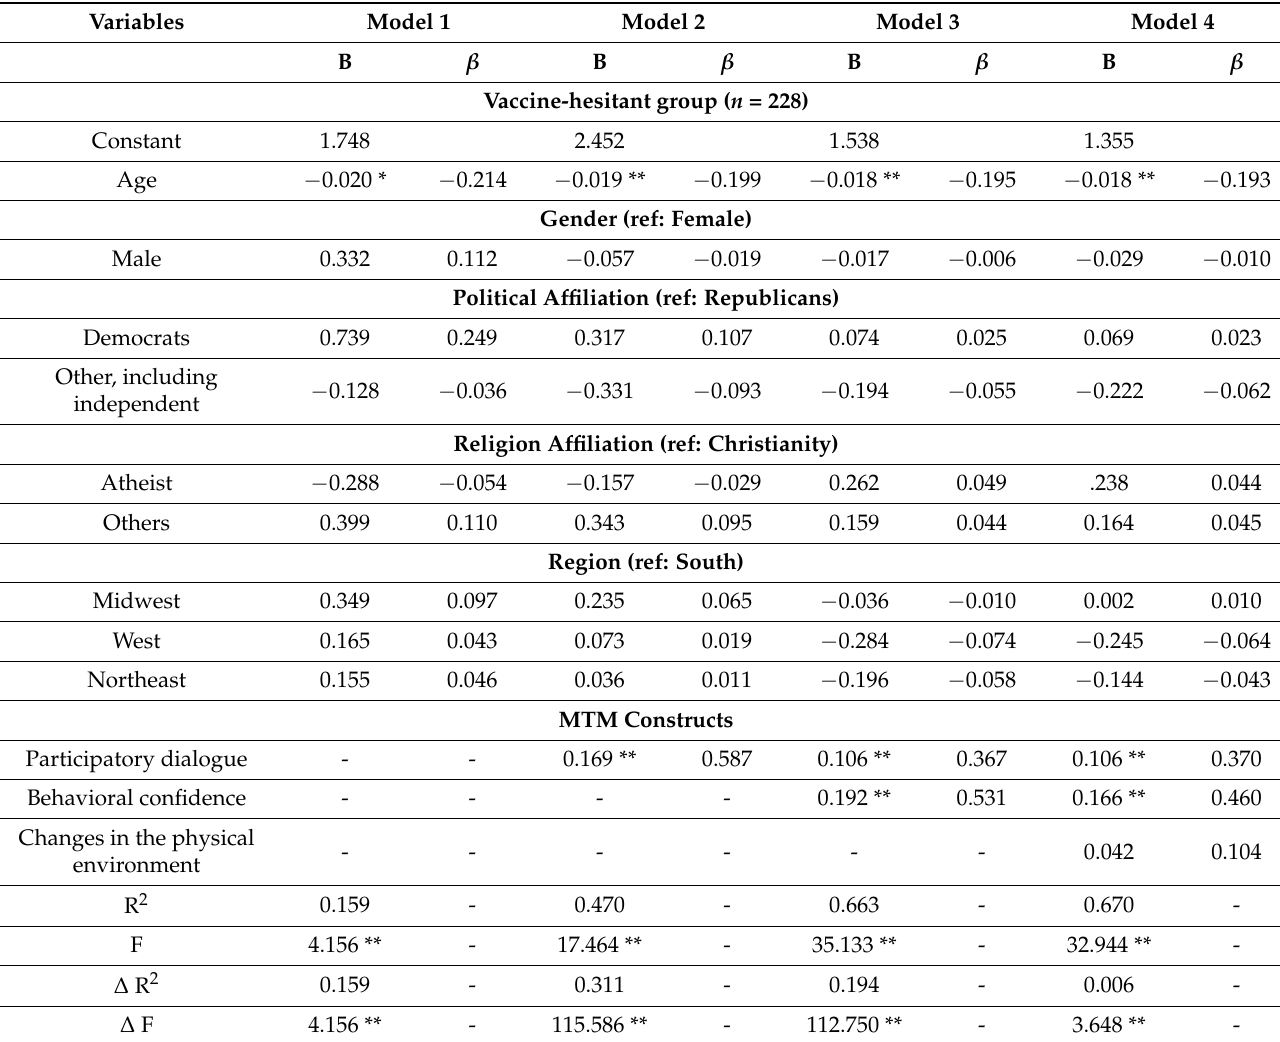
Table 5. Hierarchical Multiple Regression (HRM) predicting likelihood for initiation of COVID-19 vaccination among hesitant African Americans ( n =